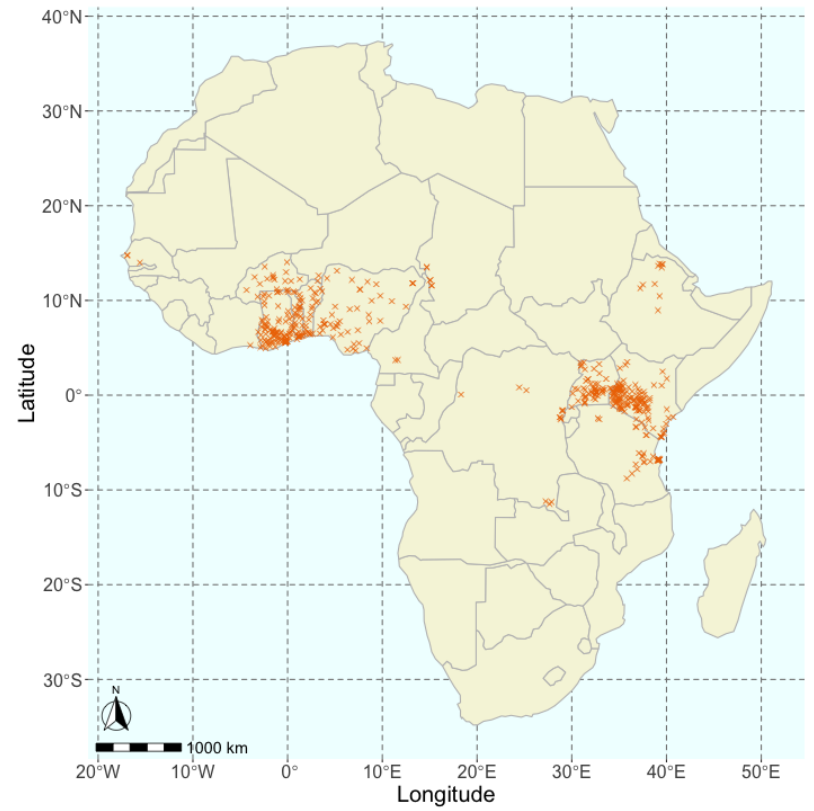
Figure 1. Location of the available TAHMO stations in sub-Saharan Africa